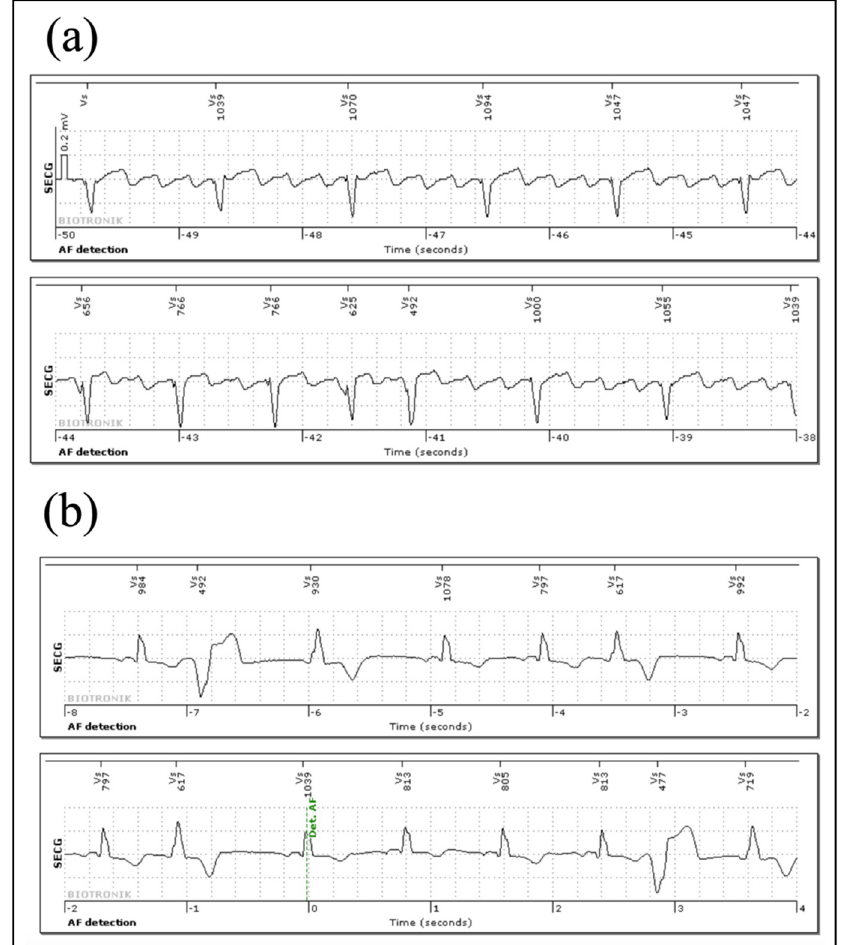
Figure 3. Subcutaneous ECG examples: ( a ) Correct classification as atrial fibrillation in a subcutaneous ECG showing atrial flutter; clear visualization of the P-wave improves diagnosis, and may guide the treatment. ( b ) Frequent premature ventricular contractions (PVCs); irregular R–R intervals due to ectopic beats can be misinterpreted as the start of an AF episode.